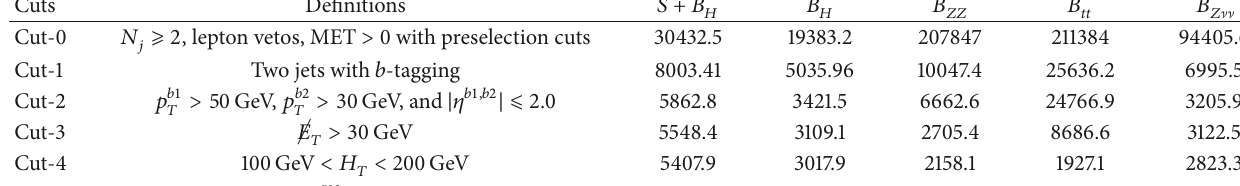
Table 2: Number of signal and background events after applied kinematic cuts used for the analysis for 𝑐 퐻푊 = 0.05 with 𝐿 int = 500 fb −1 .